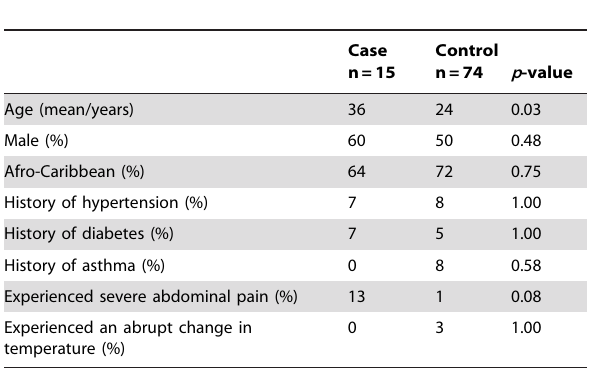
Table 1. Bivariate associations between selected factors and DHF.